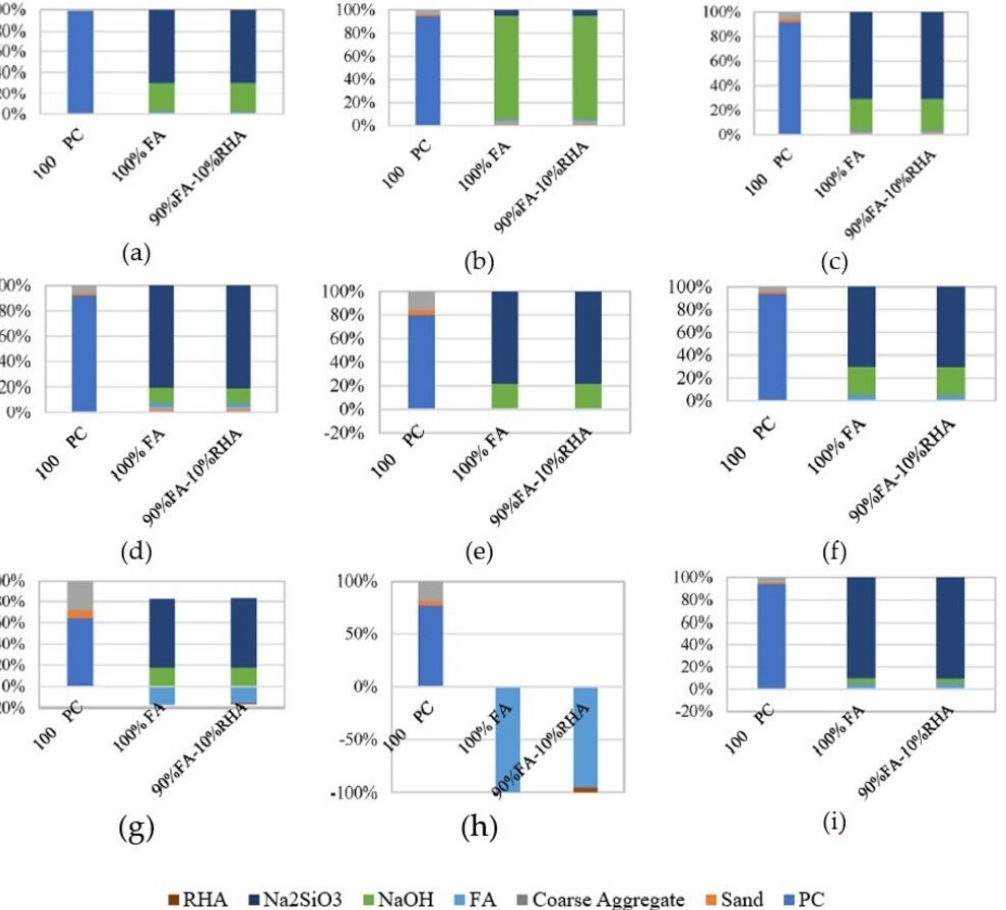
Figure 7. Contribution of the concrete ingredients to the following impact categories: ( a ) GWP— global warming potential, ( b ) AP—acidification potential, ( c ) EP—eutrophication potential, ( d ) POCP—photochemical ozone creation potential, ( e ) HTP—human toxicity potential, ( f ) ODP— ozone depletion, ( g ) FEW—freshwater ecotoxicity, ( h ) MWE—marine water ecotoxicity, and ( i ) AD—abiotic depletion [60].